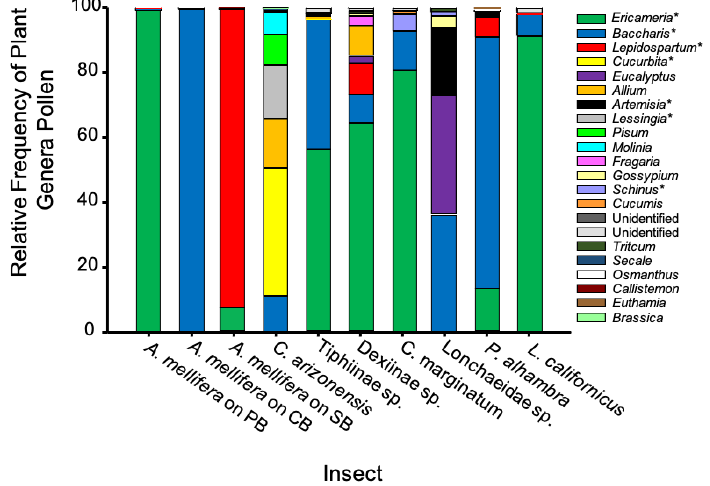
Figure 3. Relative frequencies of plant genera detected from insect pollen loads, as identified by Qiime2 using the PLANiTS database. For A. mellifera , PB = captured on E. pinifolia , CB = captured on B. pilularis , SB = captured on L. squamatum . Asterisks denote pollen from plant genera located within the BFS. We also recovered pollen from Tropaeolum , Syzygium , Eriogonum , Medicago , and Sambucus , but these each represented less than 0.1% of the sequences and cannot be seen on this graph. Eriogonum and Sambucus were also classified as plant genera found within the